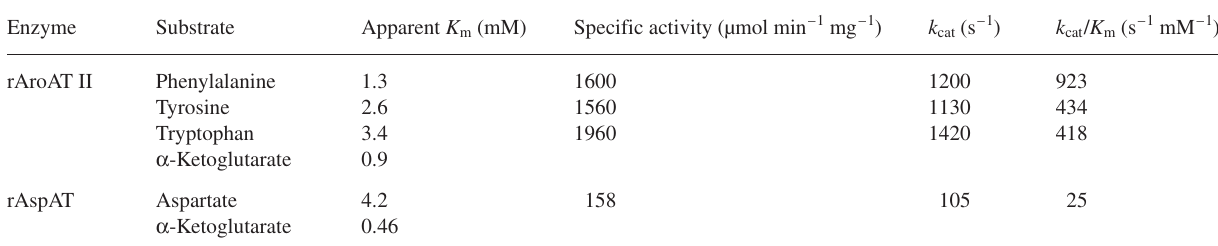
Table 1. Kinetic parameters of Pyrococcus furiosus rAroAT II and rAspAT. 1